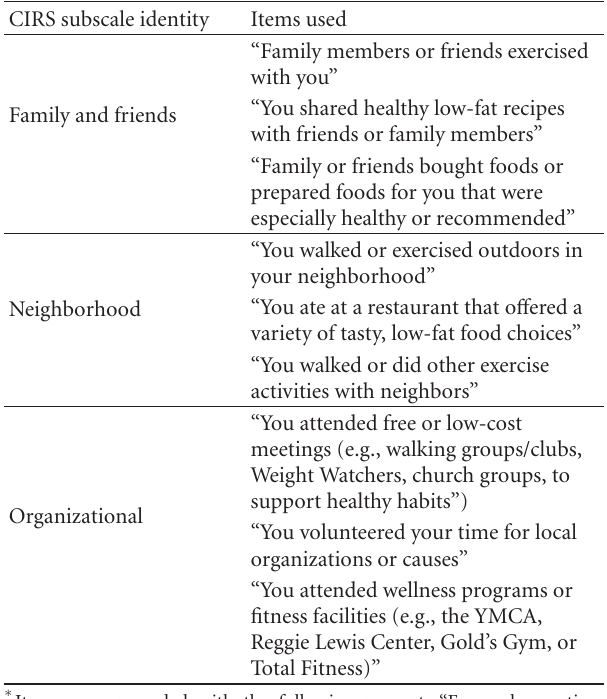
Table 1: Items from the CIRS used in our baseline survey ∗ [29]. CIRS subscale